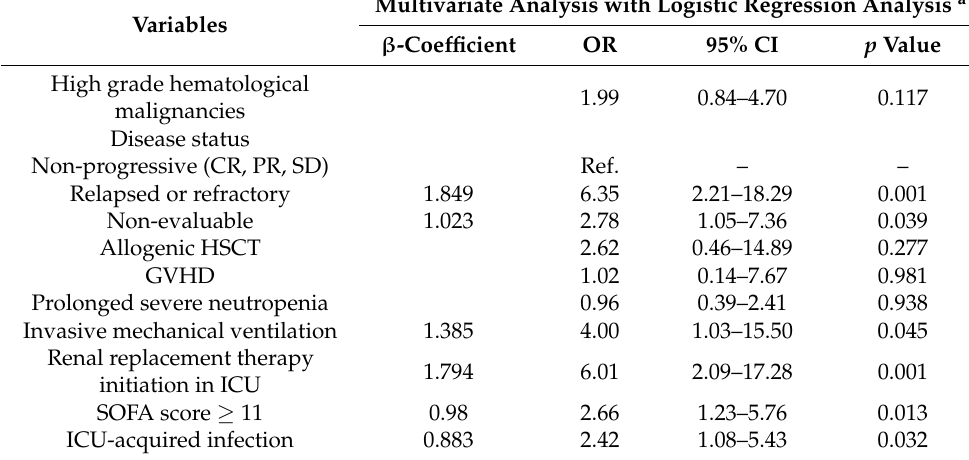
Table 4. Multivariate logistic regression analysis of the prognostic variables for hospital mortality.